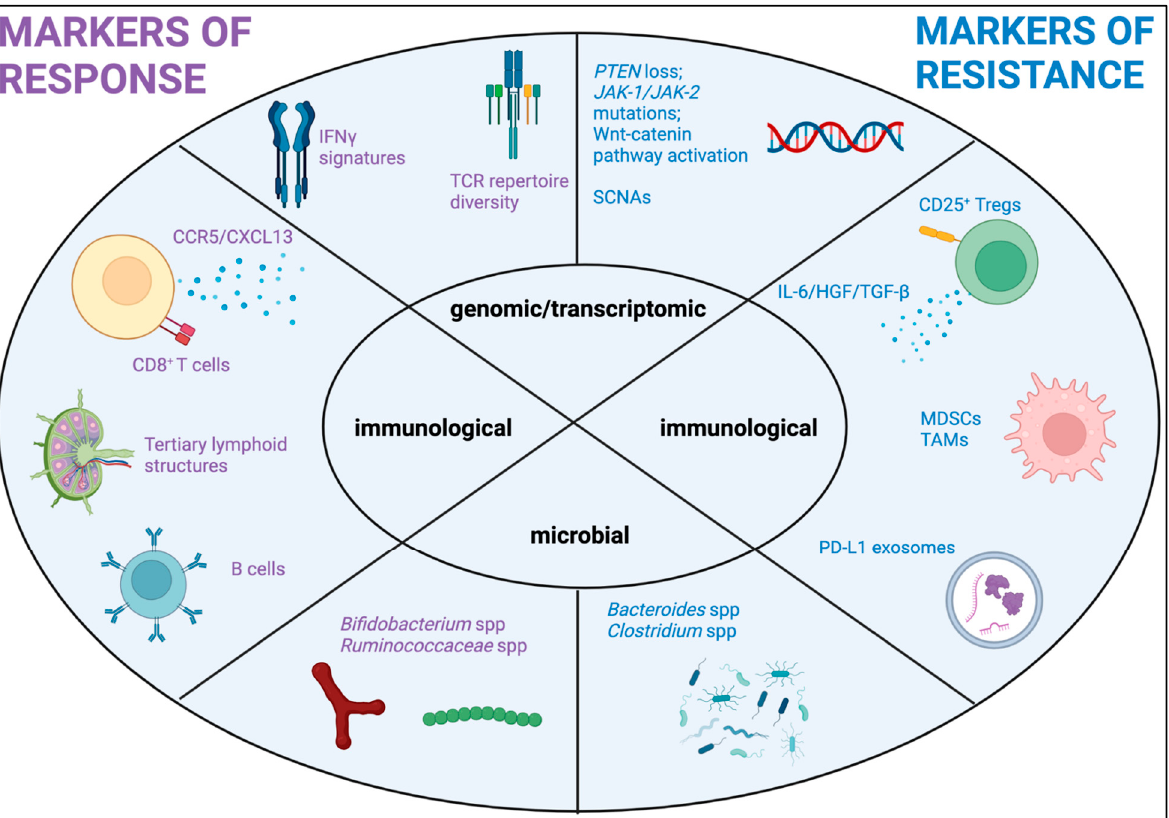
Figure 2. Biomarkers of response/resistance to immunotherapy in melanoma. purple color: markers of response; blue color: markers of resistance.